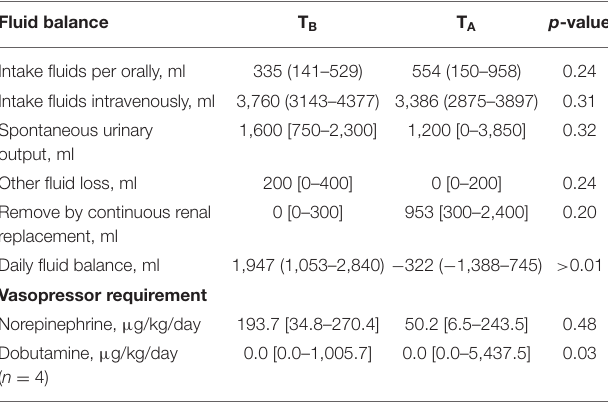
TABLE 3 | Summary of daily changes in fluid balance and inotropic support